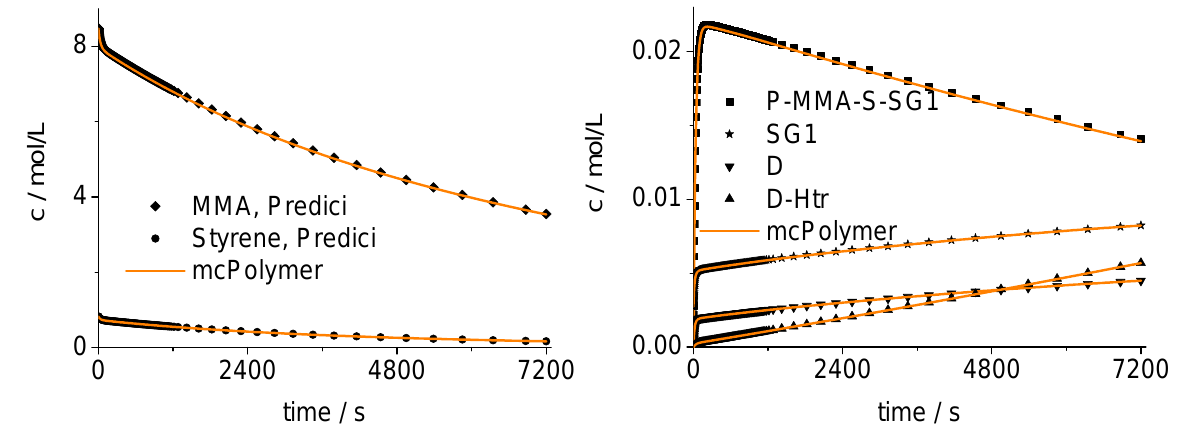
Figure 12. Validation of mcPolymer with PREDICI: Concentration-time-profiles.